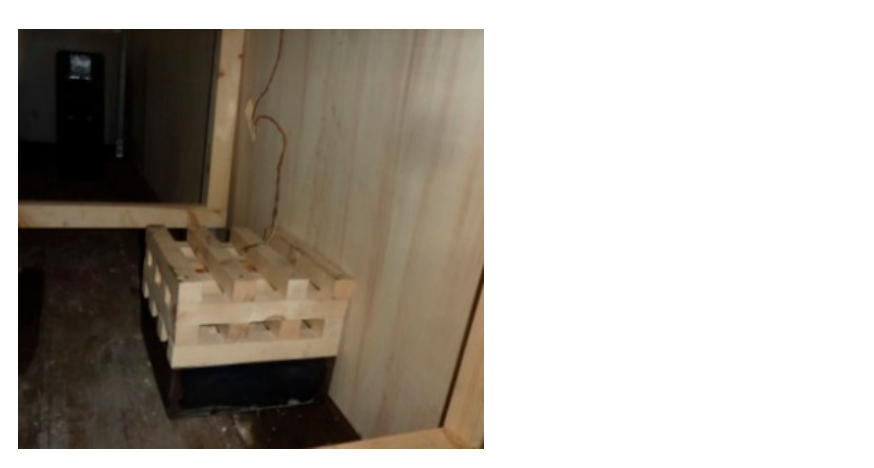
Figure 4. Wood crib/container assembly, including the container for water and accelerant (heptane). Those scenarios were aimed at reproducing typical locations of the electric heater within saunas, thus allowing one to assess the impact of the position of the ignition source on fire spread. Testing a sauna fire within a container may imply boundary and initial conditions different from those of an actual fire occurring in a real sauna. The thermo-hygrometric operating conditions of most saunas consist of 80 ± 5 ◦ C ambient temperature and 10 ± 2% relative humidity [30], as opposed to steam baths that feature lower temperature and higher humidity. Initial room temperature and heat transfer may bear the main discrepancy with respect to real scenarios. As an assessment of the potential impact of this parameter on fire development, initial room temperature was governed in one of the performed tests and raised above 80 ◦ C by an industrial heater. However, when not imposed, its variations and variations of the global heat-transfer coefficient were assumed negligible with respect to temperature rise due to a fire event [31]: in fact, even significant changes in the heat-transfer coefficient between a compartment and its outer environment, under natural convection, may affect room temperature by less than 10 ◦ C, whereas typical flame temperature is in the order of 1000 ◦ C. Moreover, no major impact by variations of relative humidity was also expected; relative humidity within the test chamber was not recorded, but tests were carried in summer mornings, which made relative humidity within the container arguably low. On the other hand, the use of a hydrocarbon (i.e., heptane) as the accelerant for the wood-crib fire yields water (steam) as a product of combustion reaction, but the fuel concentration was sufficiently low (i.e., about 8 mL heptane per 1 m 3 ambient air) to neglect the related raise of humidity. As a conservative measure, timber benches were left to dry out before installation, thus making them more prone to involvement with the fire, were flames to ever reach them. Notably, their moisture content may be assumed as lower than 5%, following a similar approach to the drying of timber components